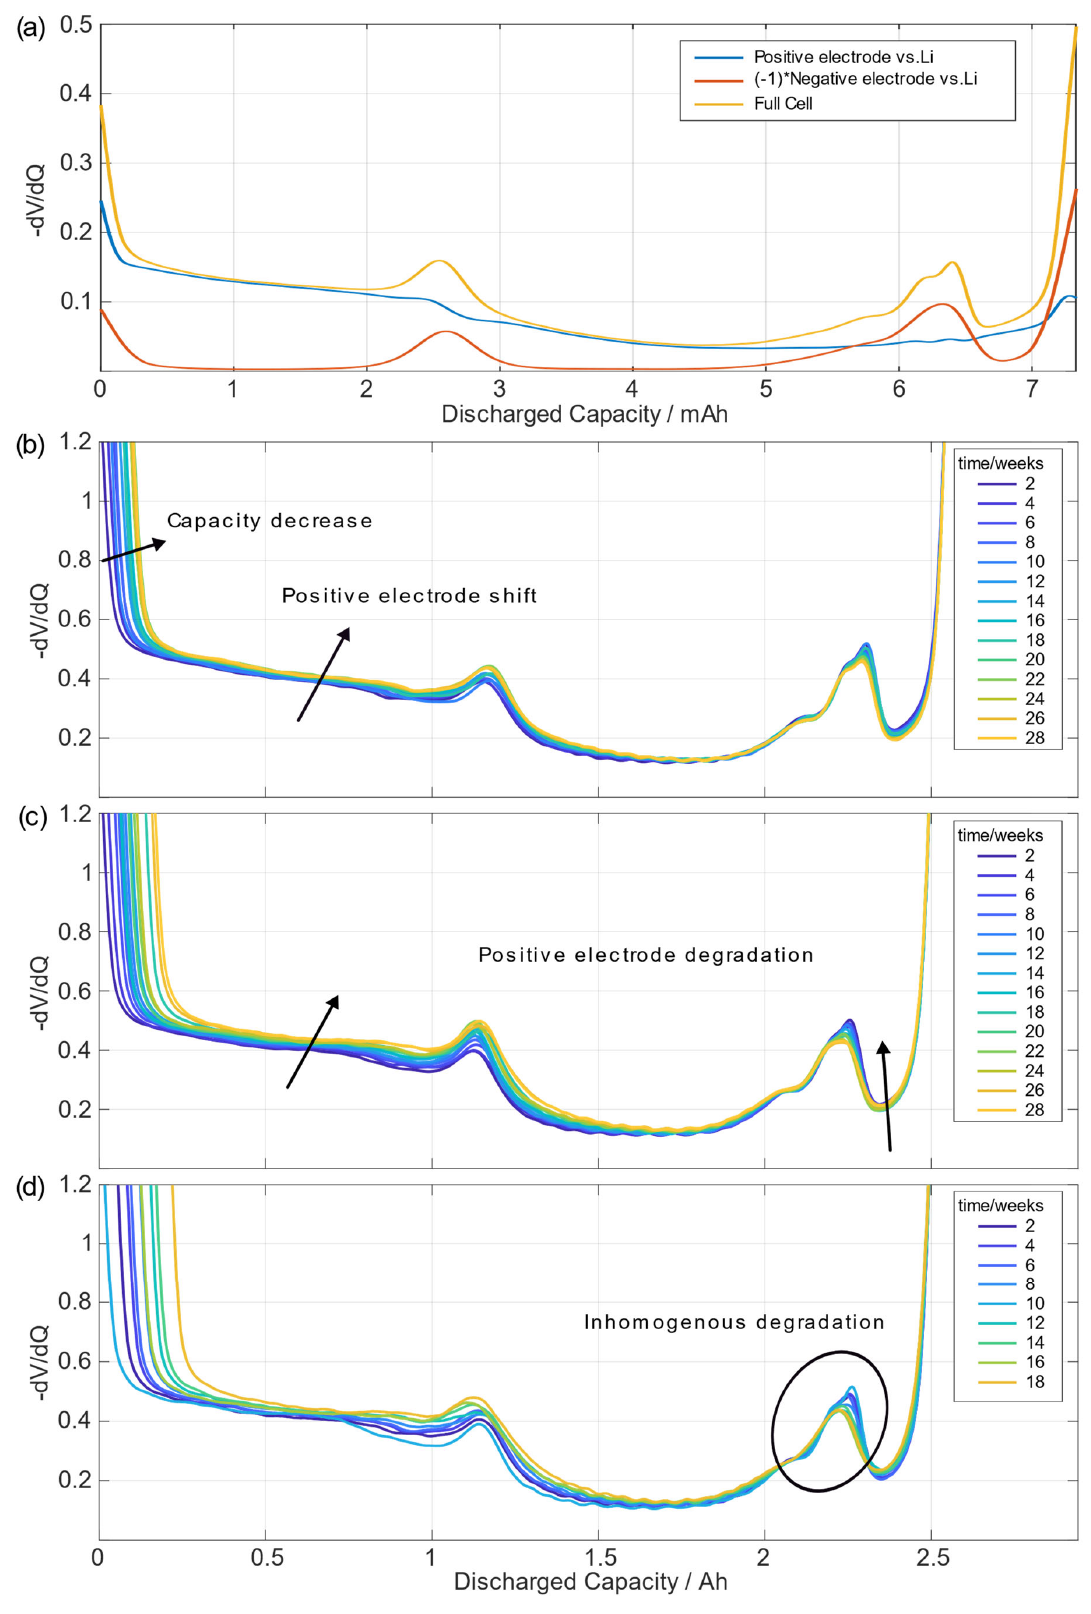
Figure 6. DVA from a three-electrode setup with a lithium reference electrode ( a ) and evolution of the cycle-aged 18,650 cells ( b ) FR, ( c ) PS, ( d ) FRPS.